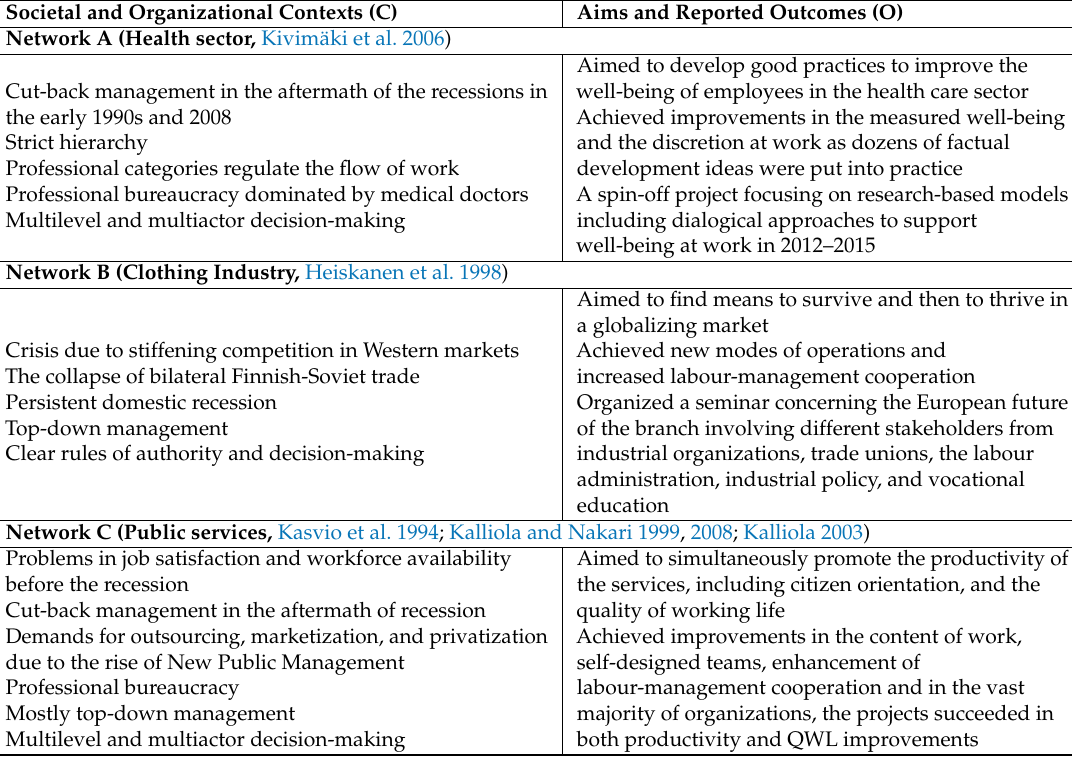
Table 1. The contexts, aims and outcomes of the